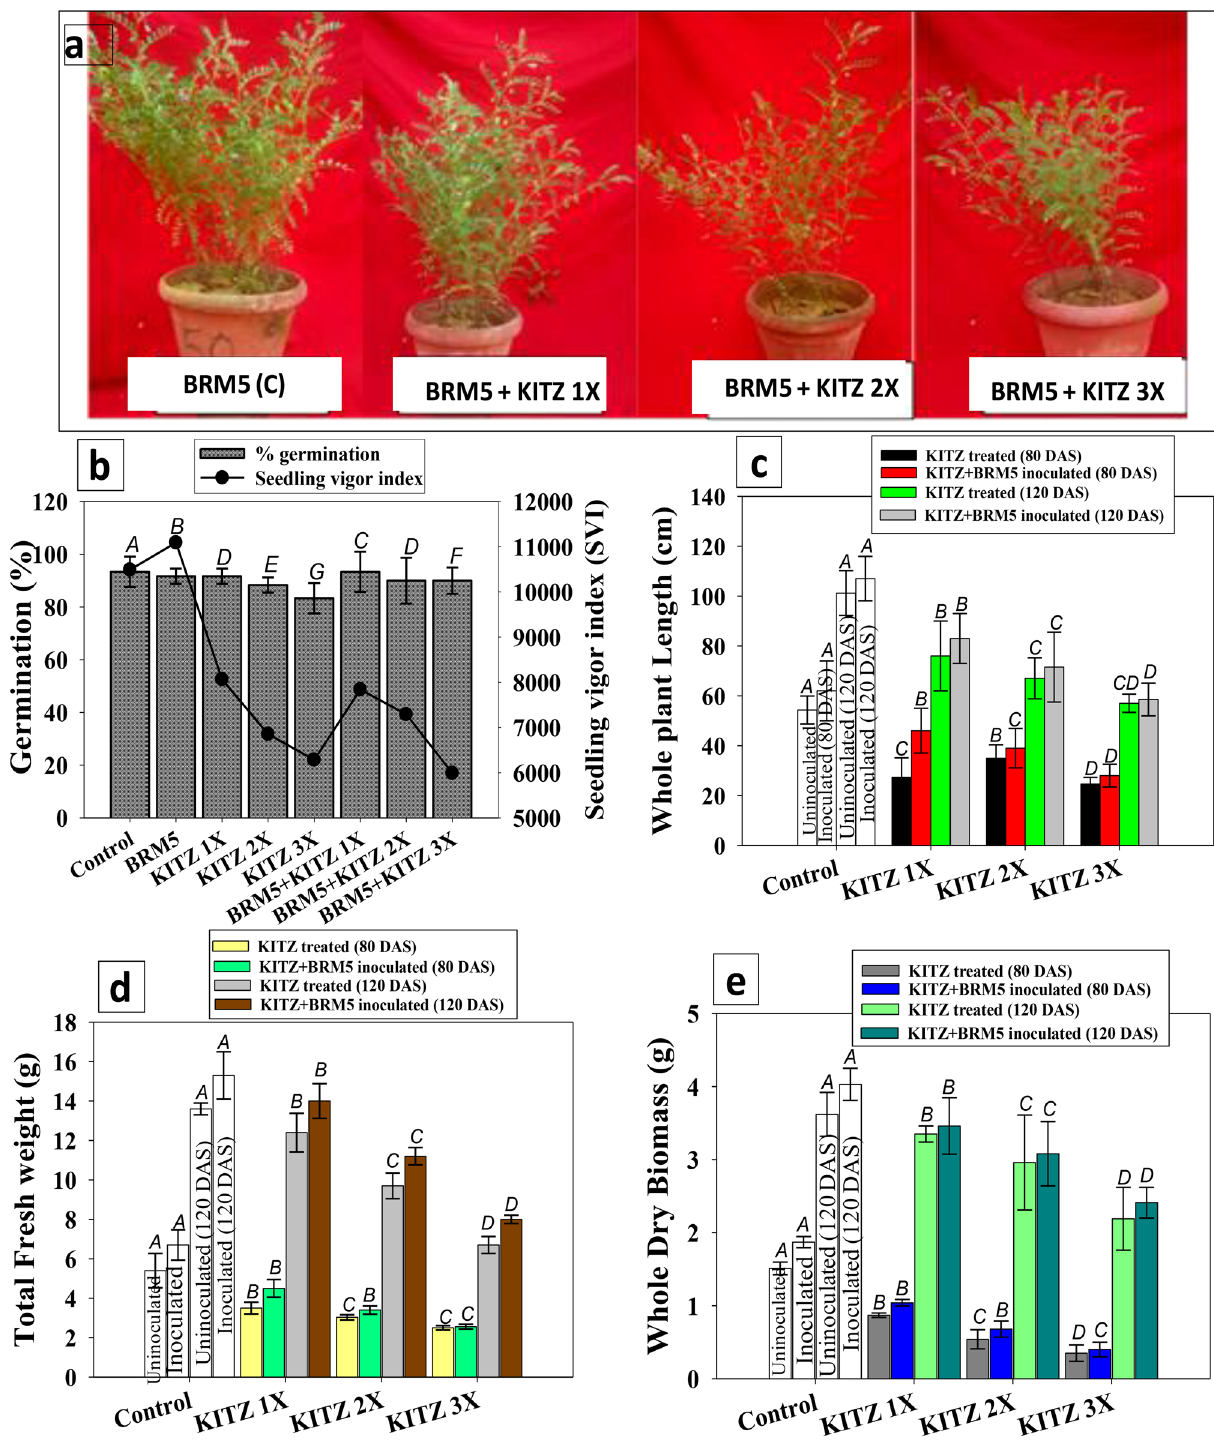
Figure 5. Inoculation impact of kitazin tolerant M. ciceri BRM5 on C. arietinum plants grown in sandy clay loam soil treated with 96 (1 ×), 192 (2 ×) and 288 (3 ×) µg KITZ kg −1 soil developed in greenhouse conditions ( a ), germination efficiency and vigor index ( b ), total plant length ( c ) total fresh weight ( d ) and total dry biomass ( e ). The bar and line diagrams represent mean ± standard deviation (S.D) ( n = 3) of three replicates where each replicate constituted three plants/pot. Mean values followed by different letters are significantly different at p ≤ 0.05 according to DMRT